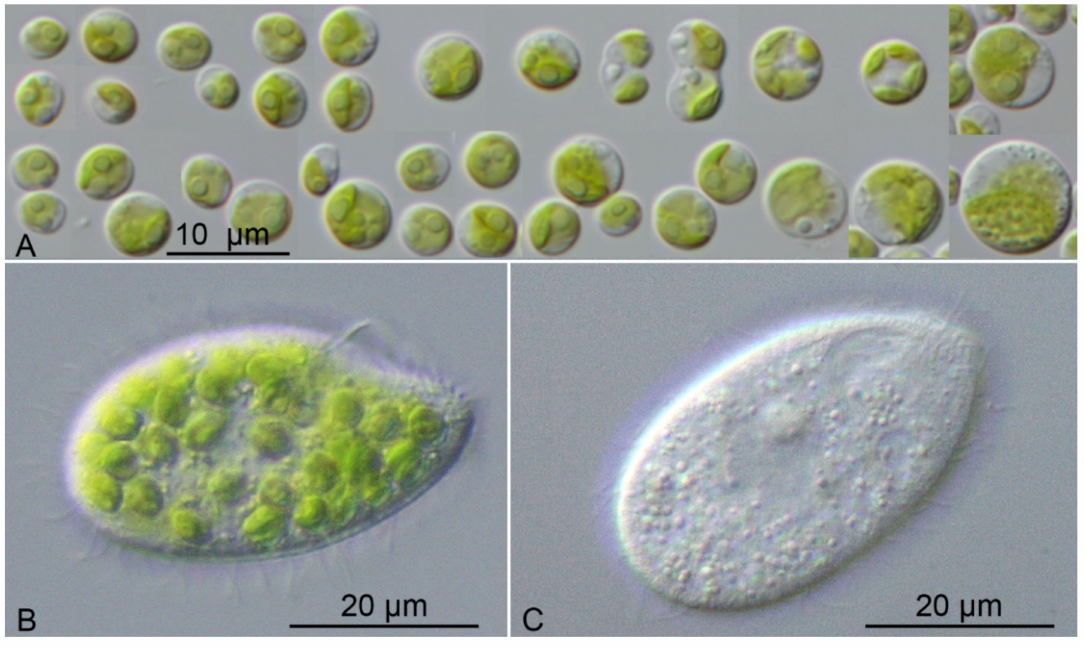
Figure 1. A. Morphology and phenotypic plasticity of Micractinium tetrahymenae , strain SAG 2587, B.-C. Tetrahymena utriculariae under anoxic (B) and oxygenic (C)